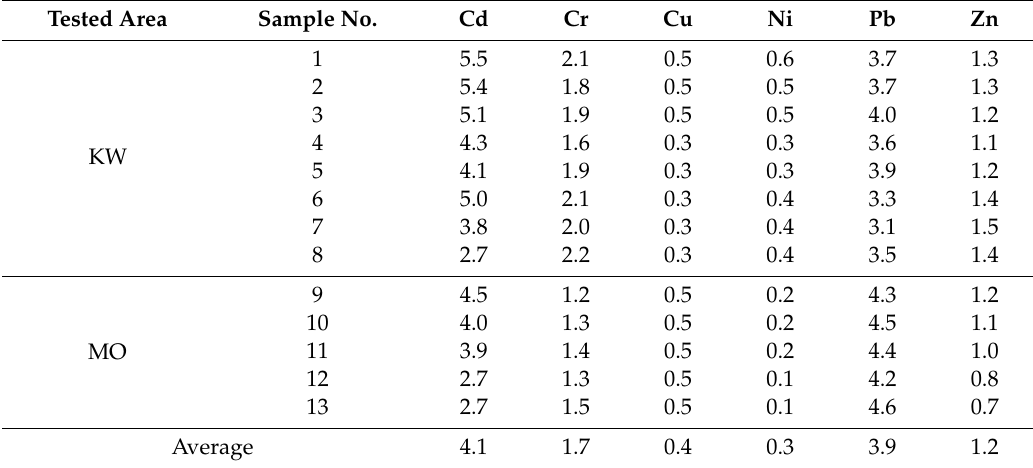
Table 4. Enrichment factors (EFs) for soil samples from the Kasprowy Wierch and Morskie Oko test